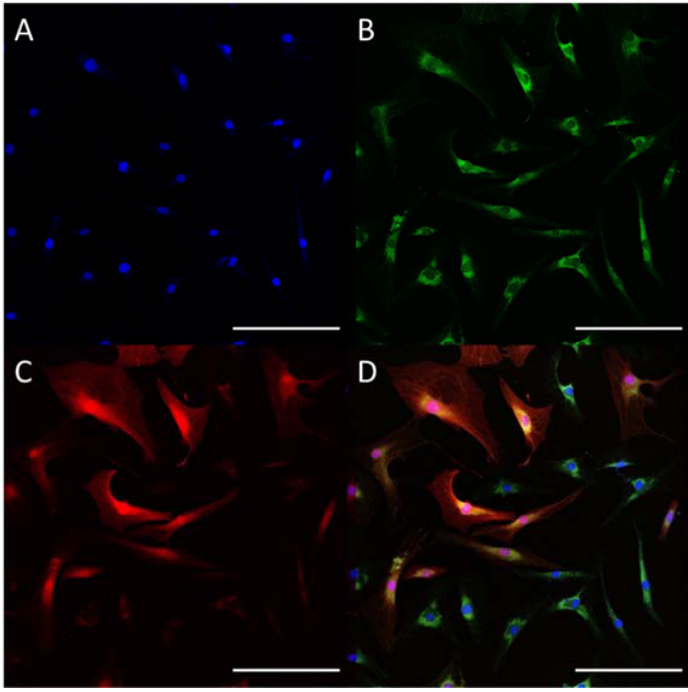
Figure 1. hAD-MSCs 48 h after infection by lentiviral vectors carrying genes encoding EncA-FLAG, EncBCD, and mZip14. Nuclei are stained with DAPI ( A ). Green channel ( B ) corresponds to GFP fluorescence; red channel ( C ) corresponds to RFP signal, ( D )—merge image. Laser scanning confocal microscopy, scale bar 200 µm.